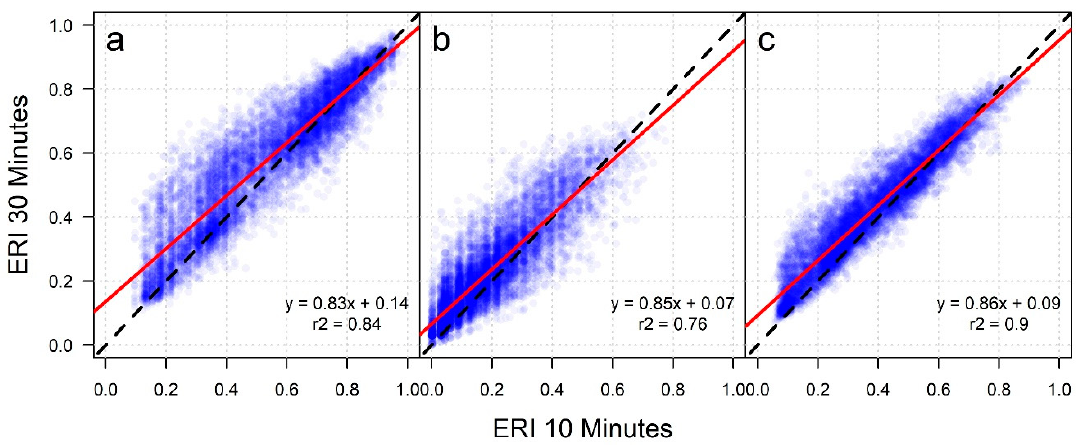
Figure 9. The e ff ects of evacuation time simulation on ERI values (30 vs. 10 min) for ( a ) ERI max ; Figure 9. The effects of evacuation time simulation on ERI values (30 vs. 10 minutes) for (a) ERI max ; (b) ( b ) ERI min ; and ( c ) ERI mean ERI min ; and (c) ERI mean.